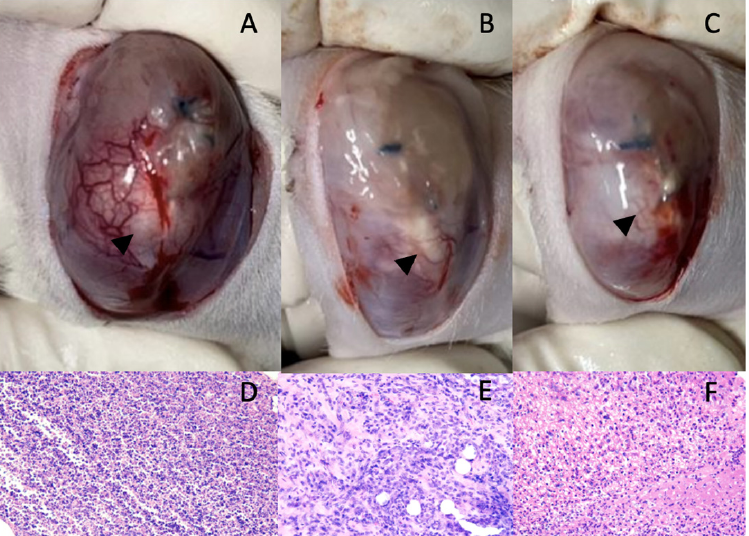
Figure 9. Representative gross image of the infected knee and corresponding histology from pericapsular tissue in non-coated ( A , D ), 1-MlTRPB ( B , E ), and 4-MLTRPB ( C , F ). Abundant pus formations (arrowheads) with prominent inflammatory cells were presented regardless of coating layers.